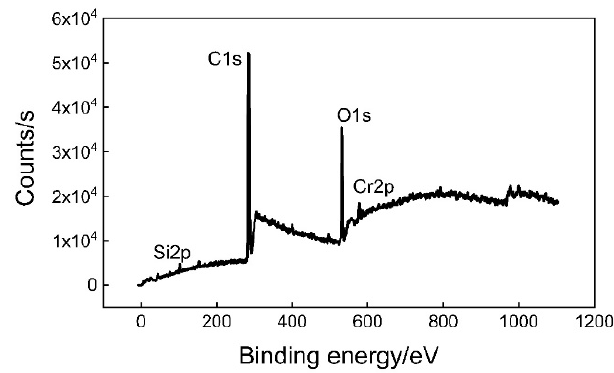
Figure 7. The SEM images and EDS curve of the blank steel and TFS.